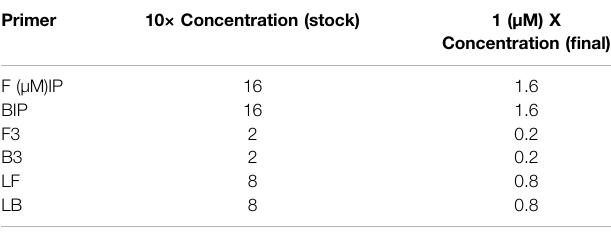
TABLE 1 | Concentrations of each oligonucleotide in the 10× primer mix.